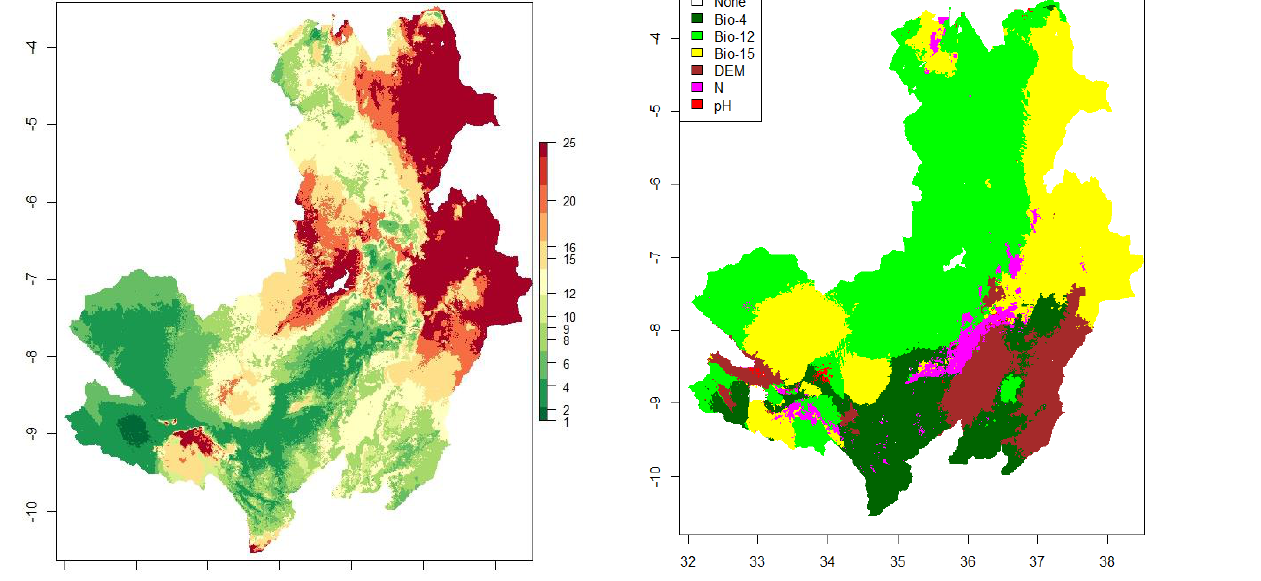
Figure 4. The extrapolation suitability index (ESI) for SC-719 maize variety and with inorganic fertilizer blend (YaraMila- CEREAL and YaraBela-Sulfan). ESI value 1 depicts high suitability while 25 is least suitable.